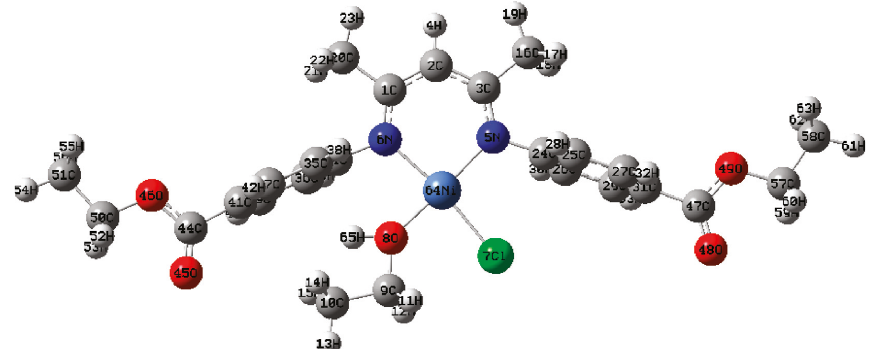
Figure 3: Structure of the model compound used to evaluate M062x/6-31G(d) for geometry optimization of the Ni(II) - β -diketimine complex 2 .